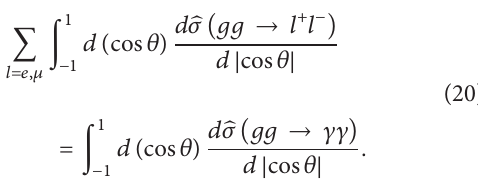
Figure 9: (a) The invariant mass distributions ( 𝑑𝜎 𝑙𝑙 /𝑑𝑀 𝑙𝑙 ) for signal and background ( 𝑝𝑝 → 𝑋 + 𝑙𝑙 + 𝑌 ) of the lepton pair after applying the cuts defined in (18) at the 14TeV LHC. (b) The angular distributions ( 𝑑𝜎 𝑙𝑙 /𝑑 cos 𝜃 𝑙𝑙 ) for signal and background of the lepton pair after applying the cuts defined in (19) at the 14TeV LHC. For both plots, we take 𝑀 𝑆 = 1.5, 2.0, and 2.5 TeV and 𝑛 = 2 for signal and Δ𝜂 = 2 for both signal and